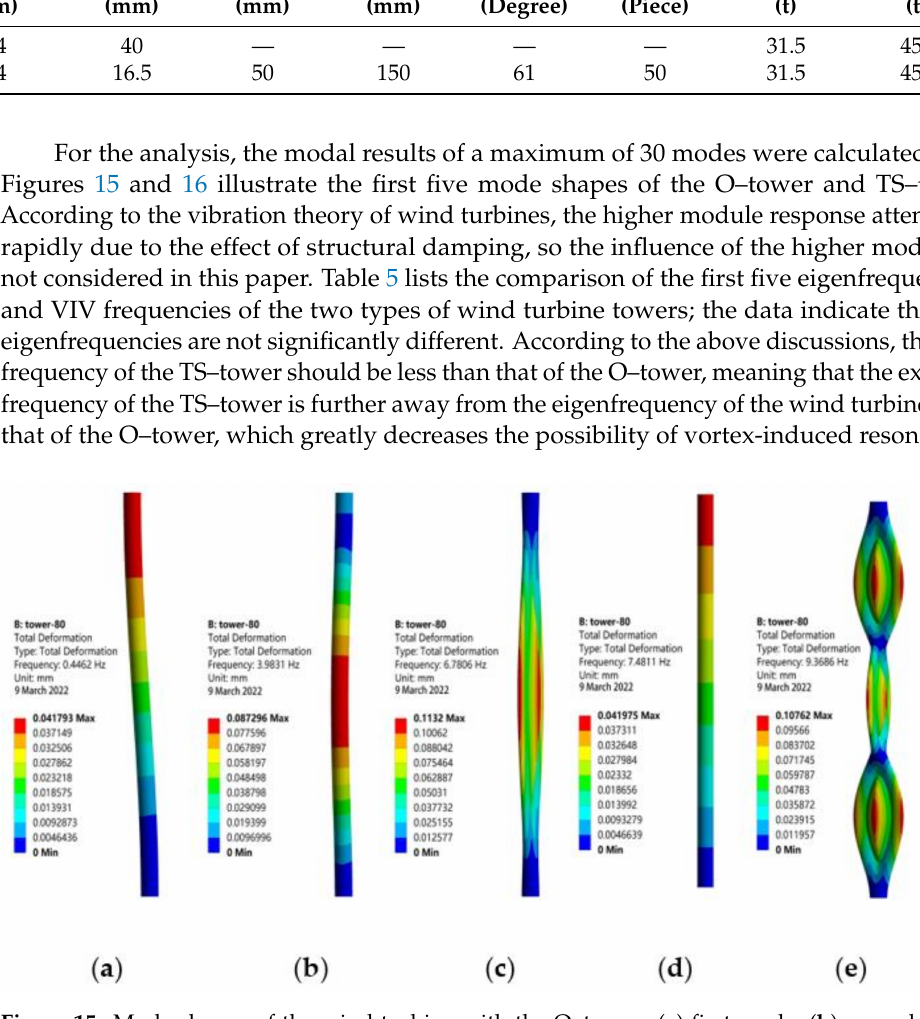
Figure 15. Mode shapes of the wind turbine with the O–tower: ( a ) first mode; ( b ) second mode; ( c ) third mode; ( d ) fourth mode; ( e ) fifth mode. Table 5. Comparison of the eigenfrequency and VIV frequency of